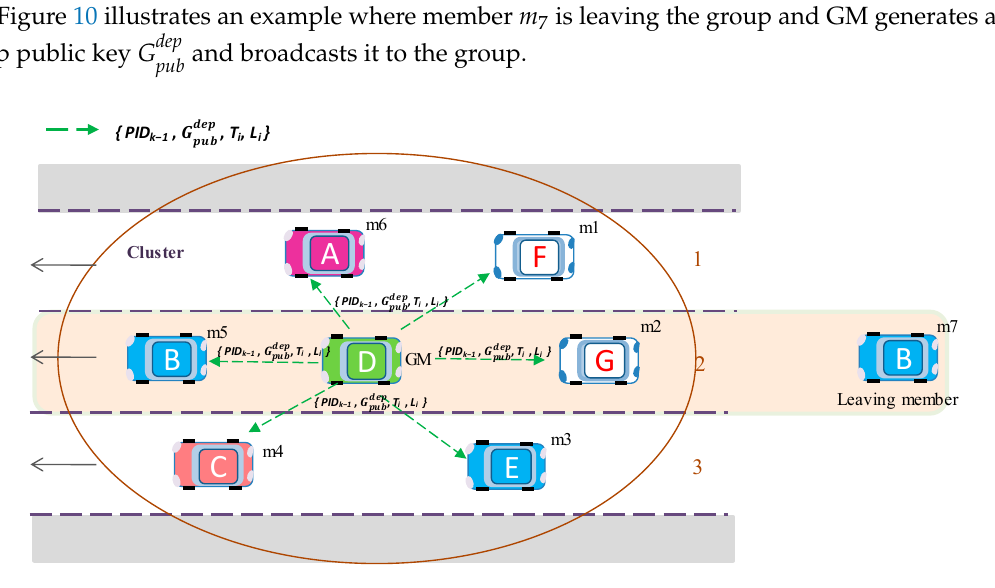
Figure 10. The rekeying mechanism for a member leaving.